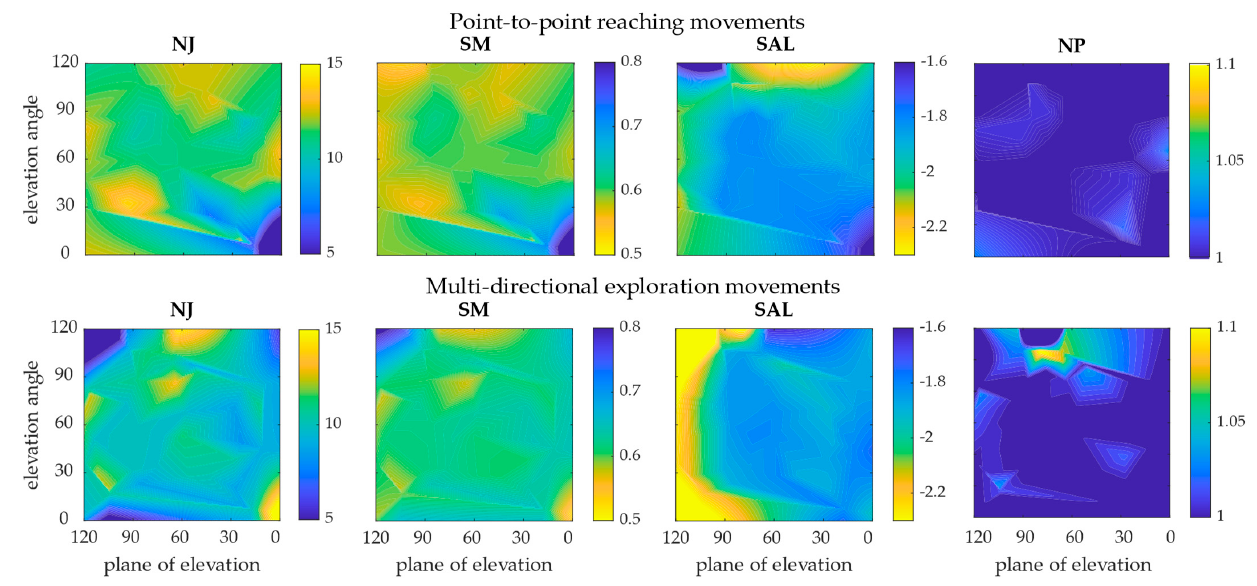
Figure 5. Color maps representing the level of smoothness with respect to articular angles. Results of the P2P movements (first row) and of the EXP movements (second row) are reported with respect to shoulder plane of elevation and shoulder elevation angle. The four metrics are represented in the columns. The blue areas represent the regions of the workspace in which the performed movement was smoother (lower NJ and NP, and higher SM and SAL); the yellow areas are the regions in which the movements were less smooth.